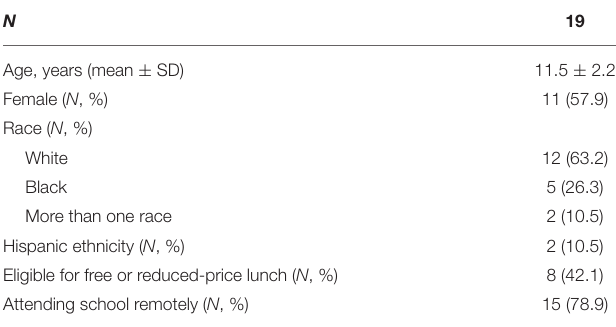
TABLE 1 | Characteristics of child participants a